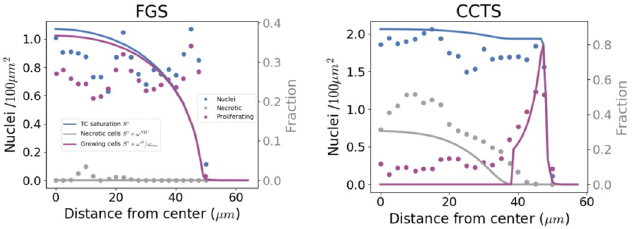
Fig 9. Qualitative comparisons of proliferative and dead cells. Quantification of proliferating and dead cells radial densities for free growth and CCTS: in vitro-in silico results. Experimental quantification along the spheroid radius (2.5 μ m sampling) of cell nuclei, blue dotted; proliferating cells, purple dotted; dead cells, gray dotted. Numerical quantities: TC Saturation S t , blue plain line; Growing TC fraction o t (see Eq 32), purple plain line; Necrotic grow saturation of TC ω Nt S t , gray plain line. A , FGS. B , CCTS, B , growth (from [7]). TC saturation almost doubles between the two configurations, in encapsulation, necrotic fraction occupy almost half of the TC phase and only a thin rim of the MTCS is viable. CCTS is very far of the conditions of parameters calibration (radius of 50 μ m vs . 100 μ m), nevertheless in vitro-in silico comparison shows a reasonably good agreement, which is quantified Table 2.